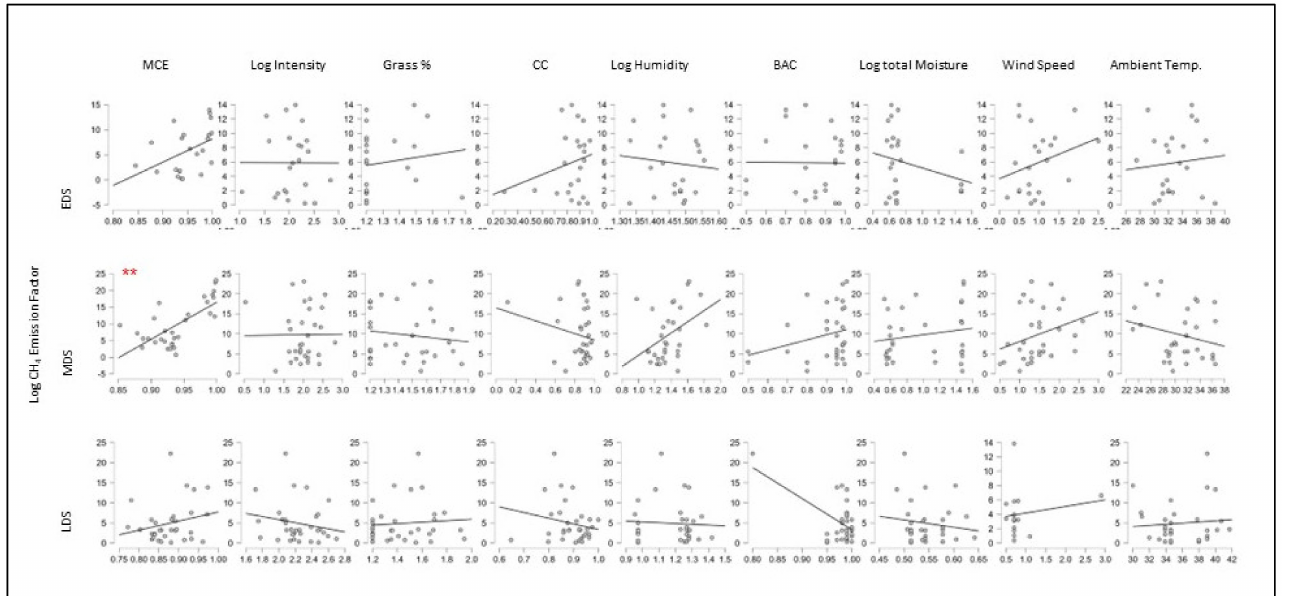
Figure 9. Methane Emission Factor ( Log ) correlations for key variables by fire season (*** p < 0.001, ** p < 0.01, * p <